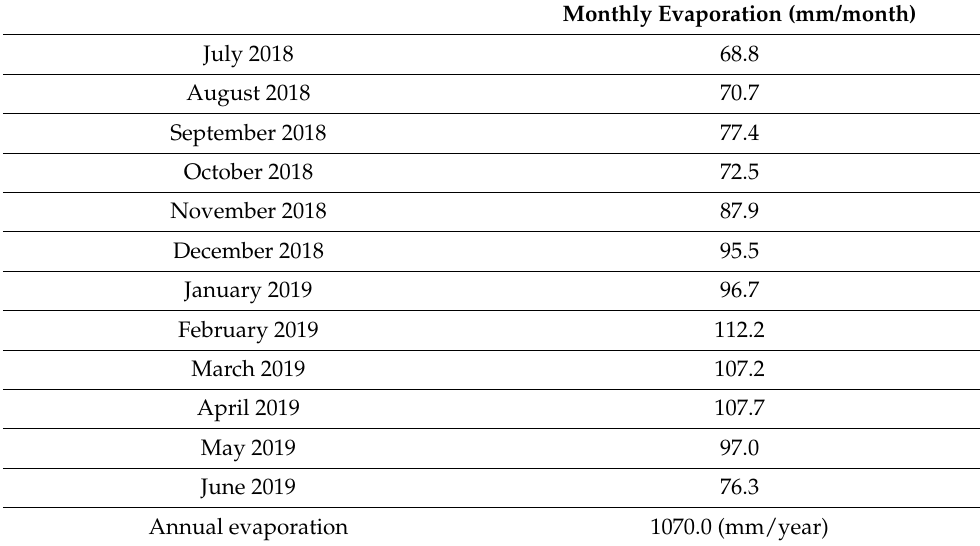
Table A2. Monthly and annual evaporation in Lakes El Sol and La